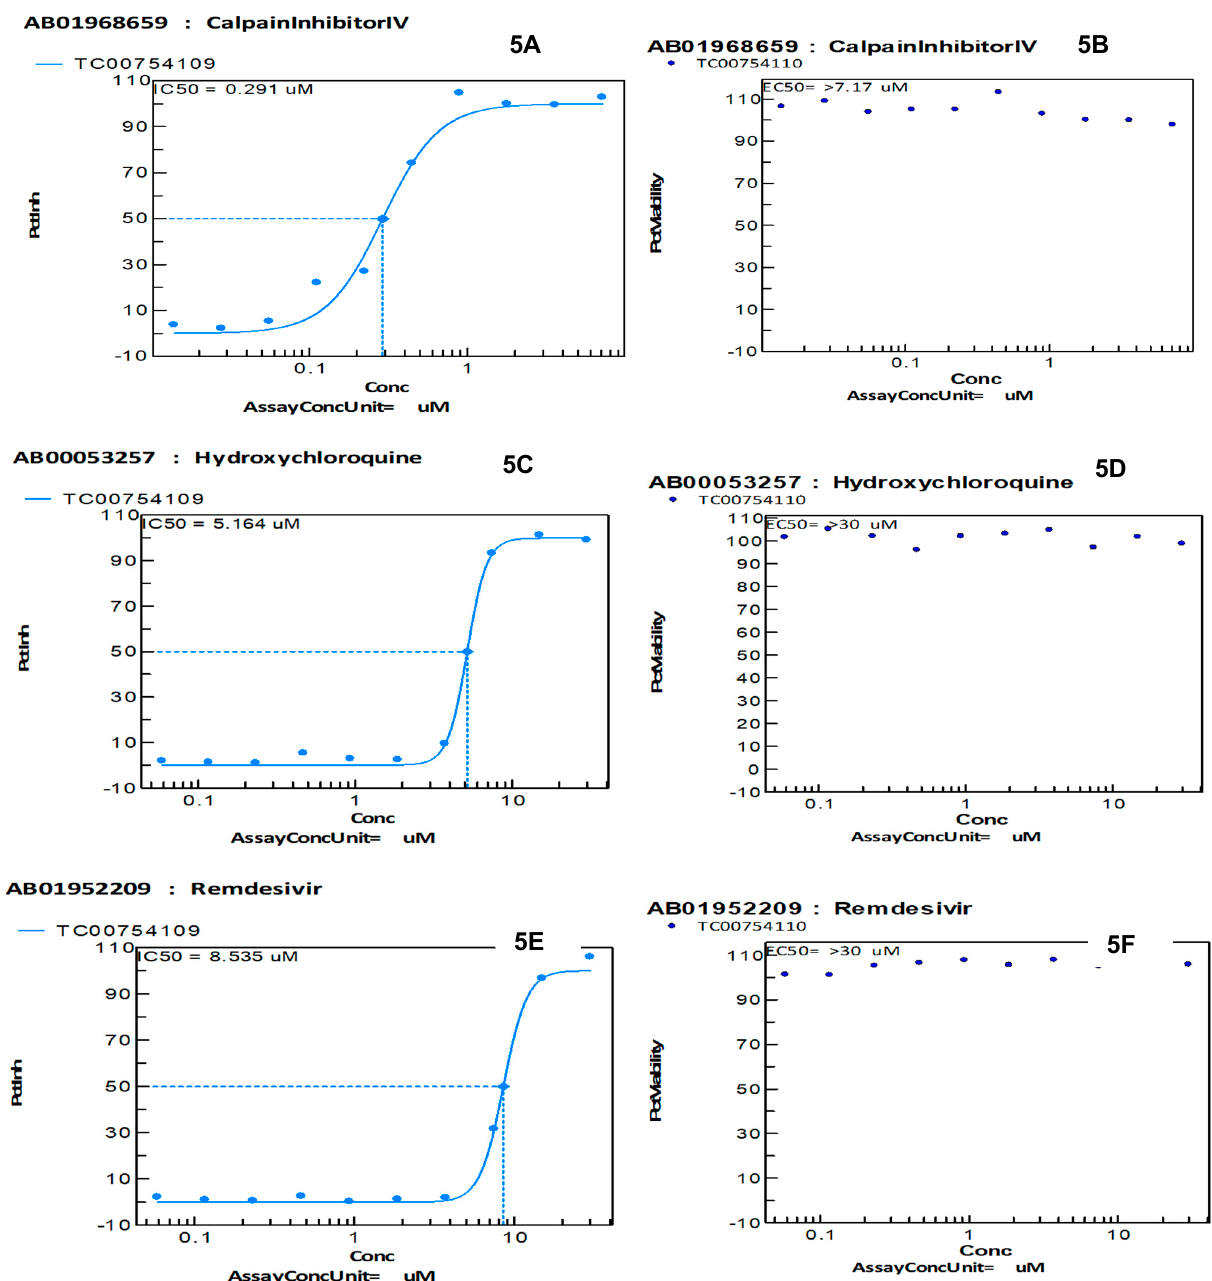
Figure 5. Calpain, hydroxychloroquine, and remdesivir inhibition of SARS-CoV-2 infection. ( A ) Calpain inhibition of SARS-CoV-2 infection in a luminescent cell viability assay with corresponding IC50 values. ( B ) Measure of calpain toxicity via a cell viability assay with no virus infection. ( C ) Hydroxychloroquine inhibition of SARS-CoV-2 infection in a luminescent cell viability assay with corresponding IC50 values. ( D ) Measure of hydroxychloroquine toxicity via a cell viability assay with no virus infection. ( E ) Remdesivir inhibition of SARS-CoV-2 infection in a luminescent cell viability assay with corresponding IC50 values. ( F ) Measure of remdesivir toxicity via a cell viability assay with no virus infection.